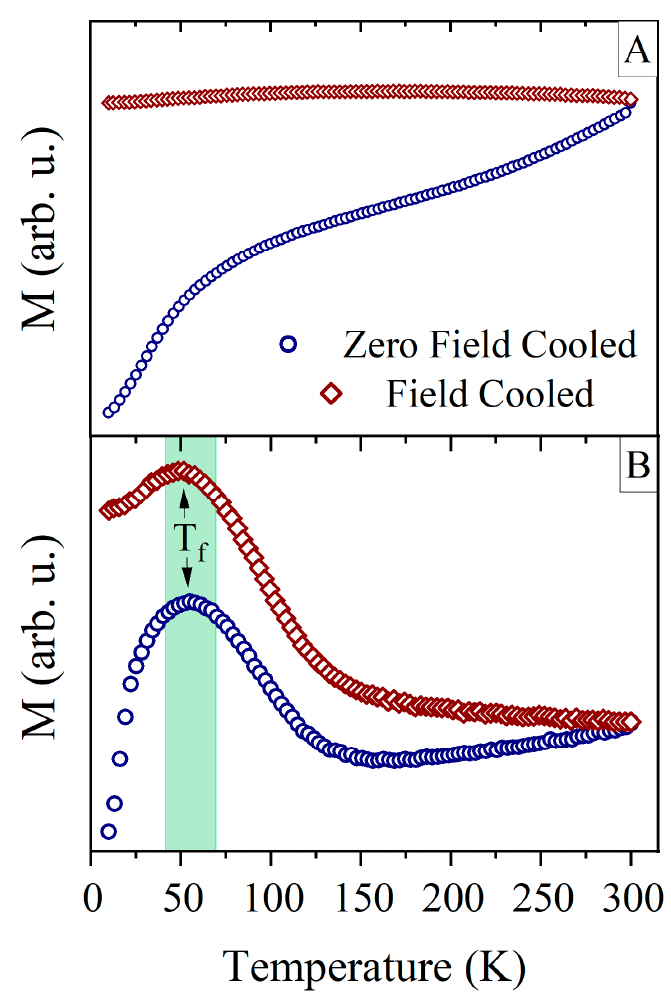
Figure 8. ZFC-FC magnetization curves for as-prepared ( A ) and annealed ( B ) sample